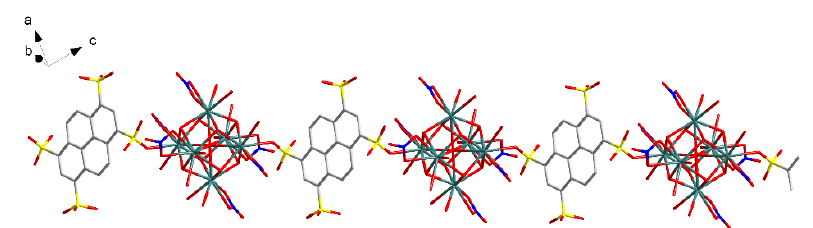
Figure 2. One-dimensional chain-like structure in compound 1.